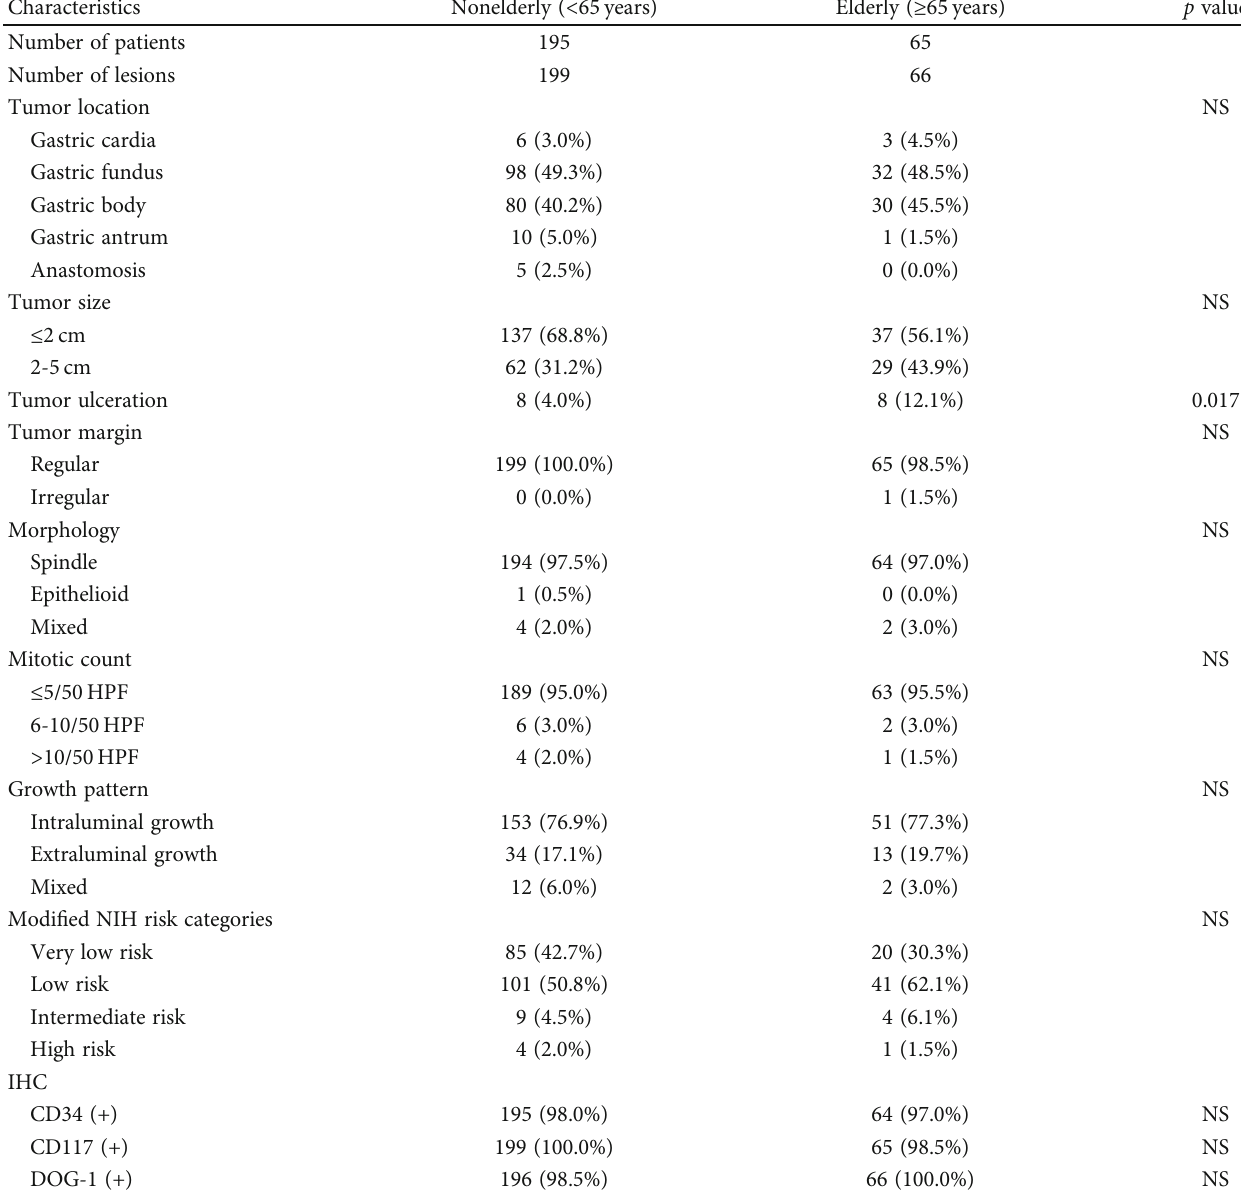
Table 2: Clinicopathological characteristics of gastric